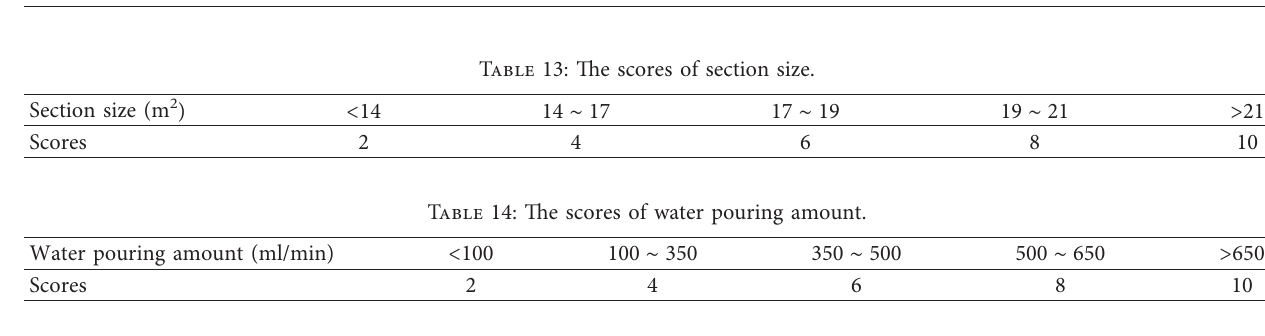
Table 15: The scores of underground temperatures.